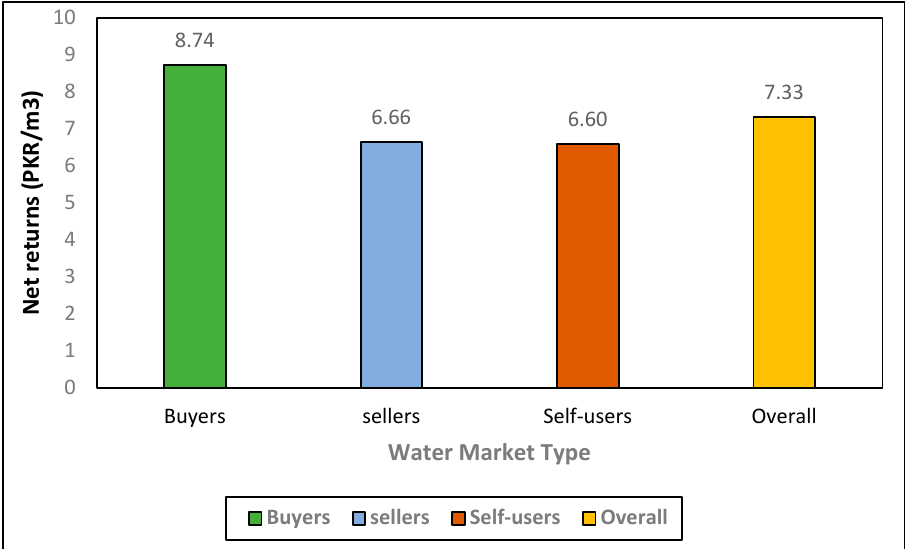
Figure 3. Incremental output ratio across water markets.